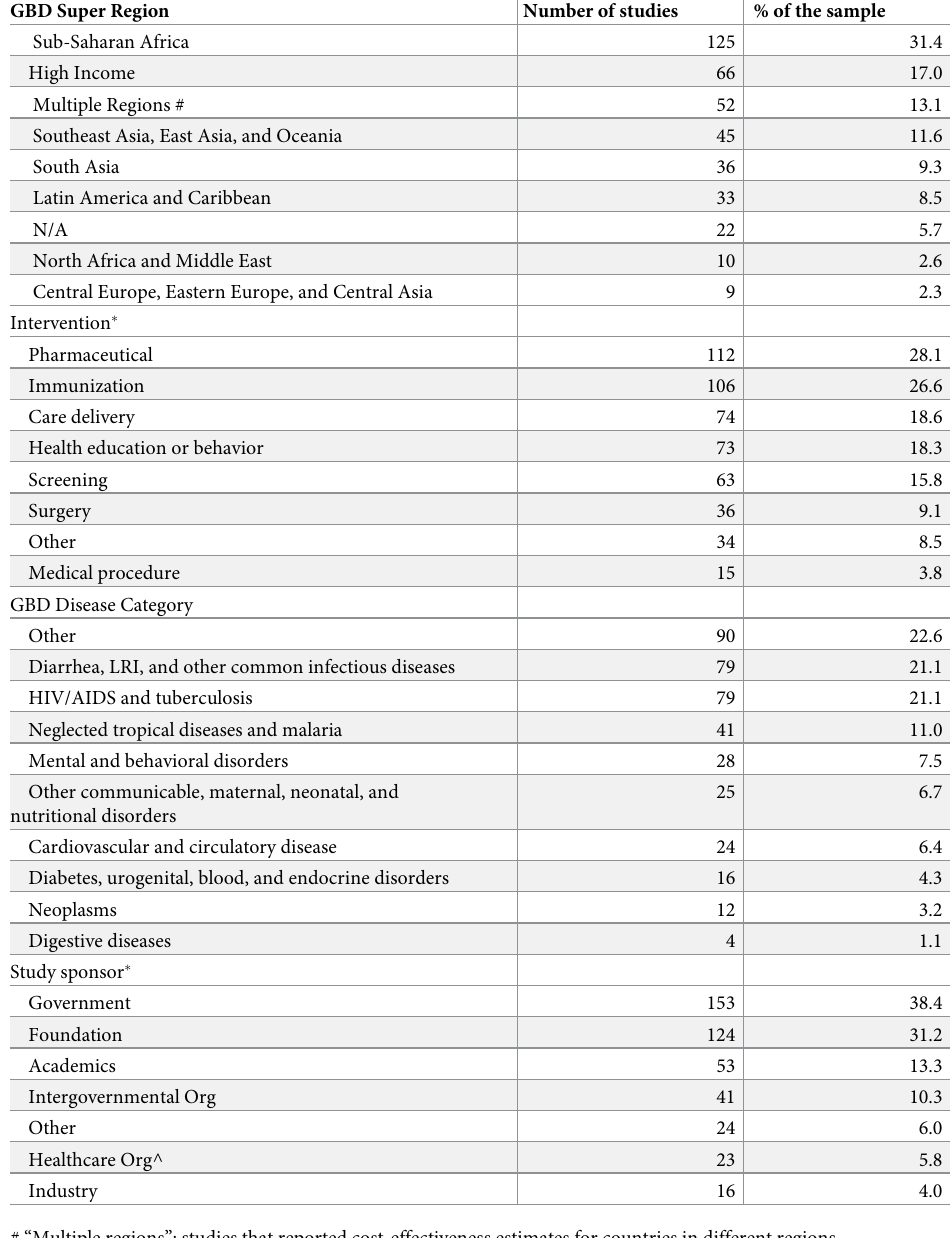
Table 2. Characteristics of cost-per-DALY averted studies published